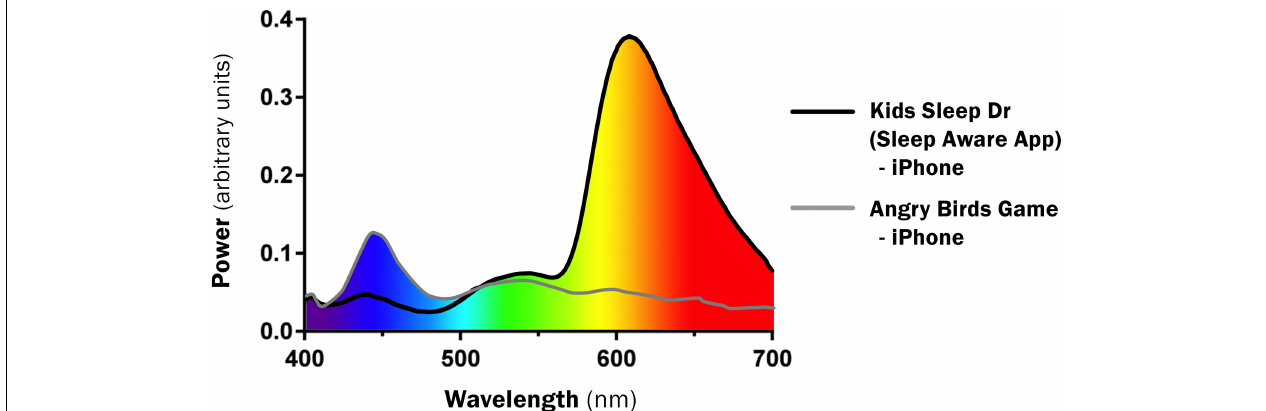
FIGURE 4 | Spectral Profile comparing ‘sleep aware’ designed game with normal game